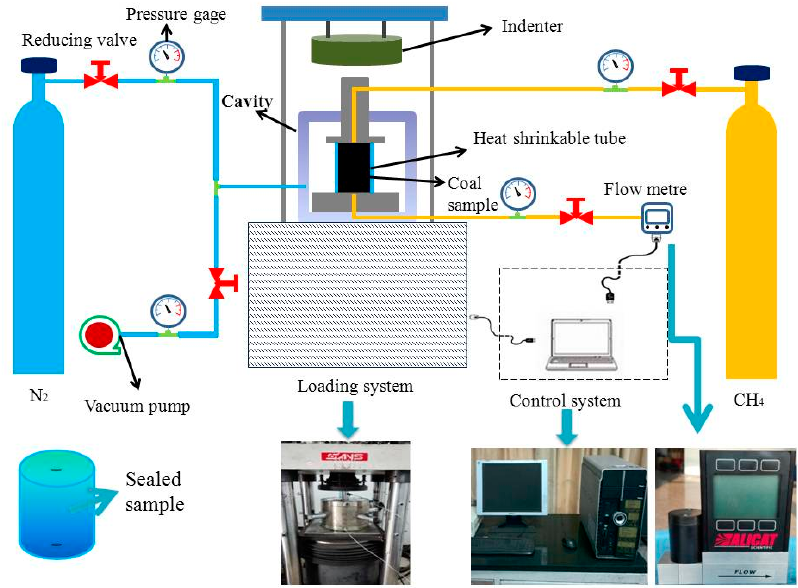
Figure 2. Schematic diagram for the experimental system.